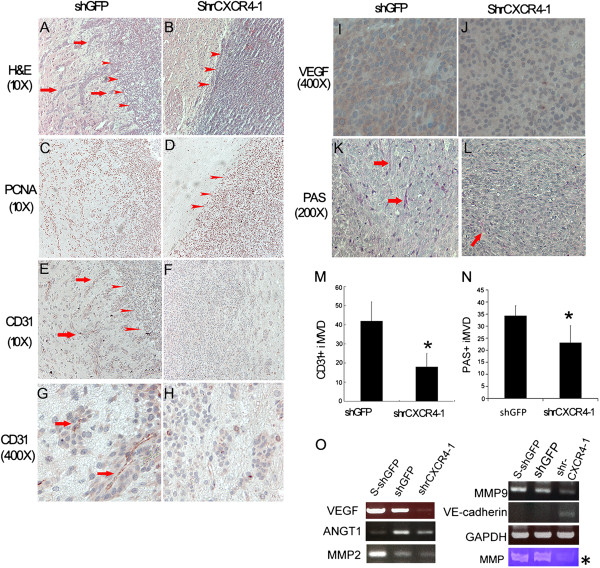
Disruption of the CXCL12/CXCR4 axis impaired the neovascularization of rat RG2 glioblastoma in vivo. (A, B) H&E staining of sections collected from orthografts showed more cells sprouting from the tumor core from the control shGFP RG2 (A) than from shrCXCR4 RG2 (B) (red arrow: sprouting RG2 cells). (C, D) Immunohistochemistry using anti-PCNA staining showed more proliferating cells spreading in the sections collected from grafts of shGFP RG2(C) than those from shrCXCR4 (D). Immunohistochemistry using anti-CD31, an endothelium cell marker, showed more CD31-positive microvessels in the grafts derived from shGFP RG2 (E, G) than in those derived from shrCXCR4 (F, H). The CD31 positive tubes were sprouting from the tumor core in the sections from the grafts of shGFPRG2. (red arrows, CD31 positive vessels surrounded by cancer cells). (I, J) The levels of VEGF were reduced in the grafts derived from shrCXCR4-1 RG2 (I), compared to those from shGFP RG2 (J). (K, L) PAS, a marker of basement membrane staining, indicated that more PAS-positive microvessels existed in tumors derived from shGFP (K) than in those derived from shrCXCR4-1 (L) (red arrow, PAS positive tubes). (M, N) Quantitative analysis showed that the density of CD31 positive (M) and PAS-positive (N) microvessels was higher in the tumor derived from shGFP. (O) RT-PCR indicated that disruption of CXCR4 reduced the expression of genes regulating angiogenesis, including VEGF, ANGT1, MMP2, and MMP9, but not VE-cadherin. Arrowheads, the boundary of the tumor core, *result from zymography. *t test, P < 0.05.